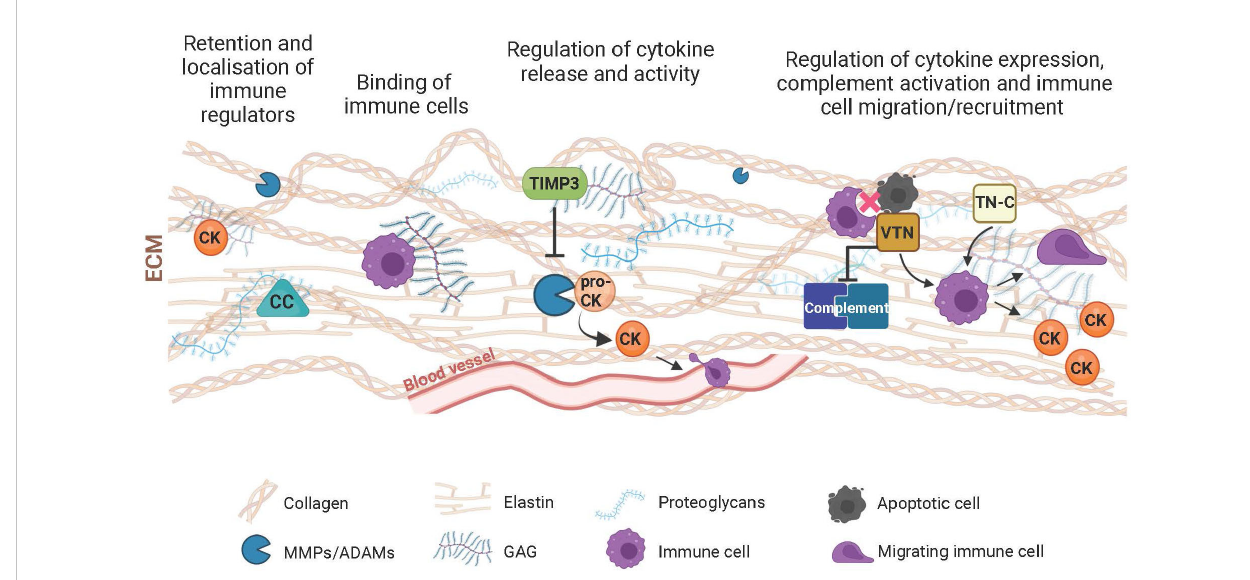
FIGURE 1 Schematic of components of the extracellular matrix (ECM) and their immunoregulatory role. The ECM participates in the control of the immune response with its structural and functional constituents through various mechanisms. Complement components (CC), cytokines/chemokines (CK) and immune cells are retained by the ECM meshwork or speci fi cally bind to its structural components such as collagen, elastin, proteoglycans or glycosaminoglycans (GAG). This results in the local activity of immune regulators. Through turnover mechanisms involving extracellular proteases (e.g., MMPs or ADAMs), the ECM in fl uences the transformation of proactive (pro-CK) to active CKs, thereby in fl uencing their in fl ammatory and chemotactic function with consequent in fl uence on the extravasation and migration of immune cells. Inhibitors of extracellular proteases, including the tissue inhibitor of metalloproteases 3 (TIMP3), further modulate immune regulation resulting from the digestion of the ECM and the in fl ammatory agents residing within. Matricellular proteins such as vitronectin (VTN) or tenascin-C (TN-C), which mediate the interaction between cells and their extracellular environment also in fl uence ECM-associated immunological processes, including complement activation, immune cell migration, phagocytic removal of apoptotic cells, and secretion of in fl ammatory